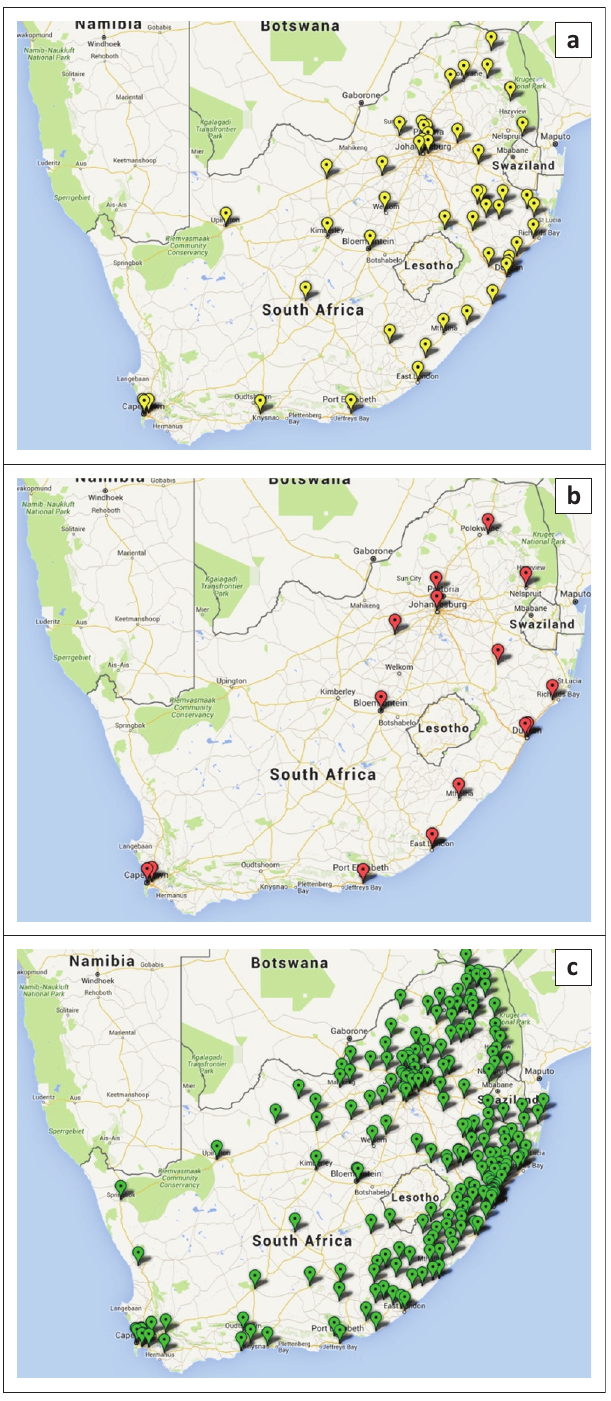
FIGURE 1: GIS map of testing laboratories implemented by the National Priority Program throughout South Africa. There are currently (a) 52 CD4 (yellow), (b) 16 viral load (red) and (c) 211 GeneXpert MTB/RIF (green) testing laboratories.